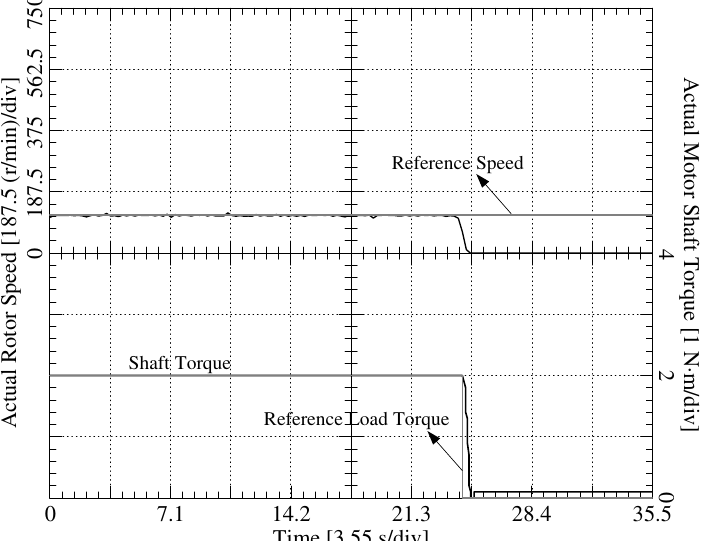
Figure 18. Experimental rotor speed waveform in a steady-state (120 r/min) and when the speed is stepped down to 90 r/min at t = 24.32 s during 82.35% higher stator resistance than the actual value and λ f is decreased by 40% of its original value using classical